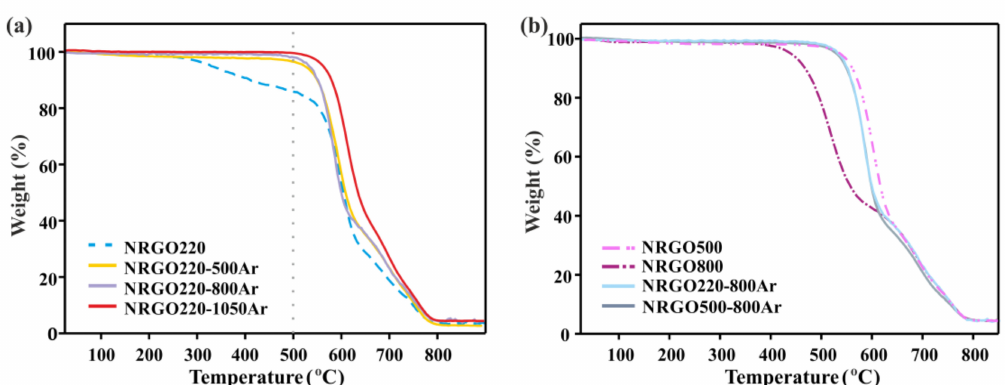
Figure 6. ( a ) Thermogravimetric analyses of NRGO220 sample before and after thermal treatment at 500 ◦ C, 800 ◦ C and 1050 ◦ C under argon. ( b ) Thermal behavior against oxidation of NRGO220 and NRGO500 after thermal annealing at 800 ◦ C under Ar (NRGO220-800Ar and NRGO500-800Ar). TGA of N-doped RGOs (NRGO500 and, NRGO800) are included for comparison. Analyses were performed under flowing air at a heating rate of 10 ◦ C · min –1 .